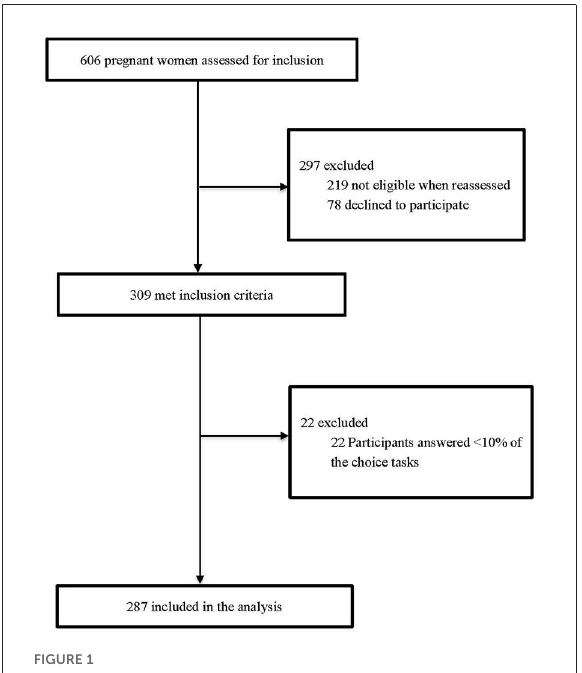
FIGURE1 Flow chart of the subject selection.